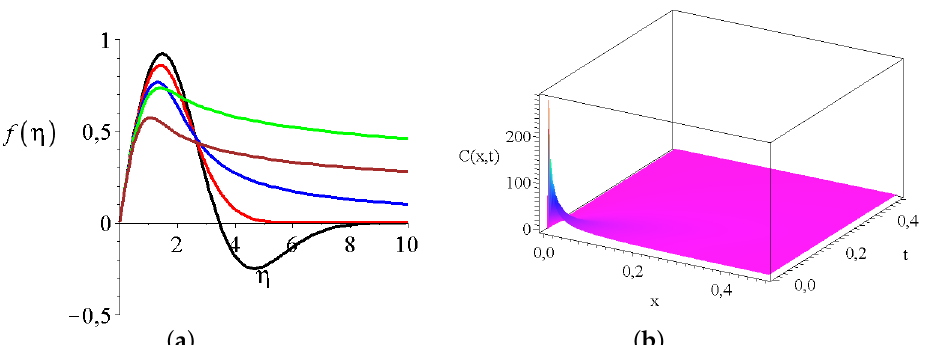
Figure 5. ( a ) Functions of Equation (45) for α = 1 where black,red,blue,green and brown lines are for β = 1/4,1/2,1,2 and 3, ( b ) The C ( x , t ) solution of Equation (46) for α = β = 1.